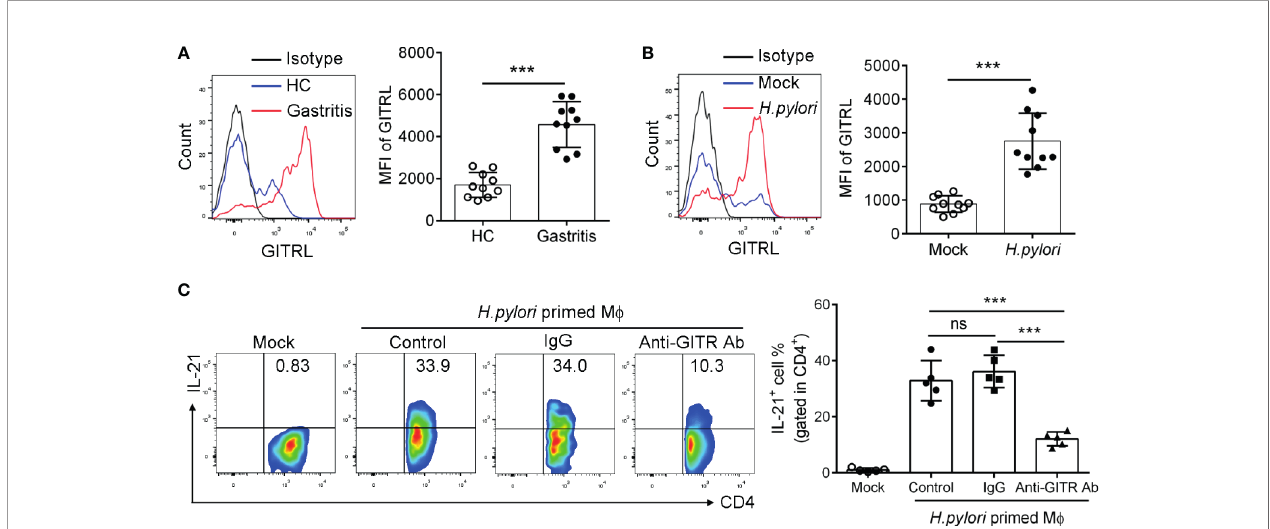
FIGURE 3 | GITRL was upregulated in macrophage and provided ligand signal to TFH-like cells in Helicobacter pylori -positive gastritis. (A) GITRL expression was determined in the mucosal macrophage of H. pylori -positive patients ( n = 10) and healthy controls ( n = 10) by fl ow cytometry. (B) Monocyte-derived macrophages (MDM) were infected with H. pylori (multiplicity of infection, MOI = 20) for 24 h. GITRL expression was assessed by fl ow cytometry. (C) MDM was infected with H. pylori (MOI = 20) and co-cultured with gastric CD4 + T cells in the presence of control IgG or anti-GITR-neutralizing Ab. At 3 days later, IL-21 production by CD4 + T cells was detected. Unpaired Student ’ s t -test was performed to determine the difference between the two groups. One-way ANOVA was used to compare among three or multiple groups. Data are shown as mean ± SD from at least three independent experiments. ns, P > 0.05; *** P <